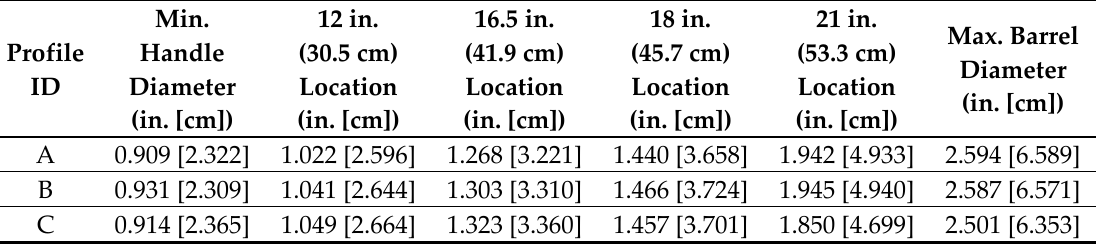
Table 2. Bat Profile Geometric